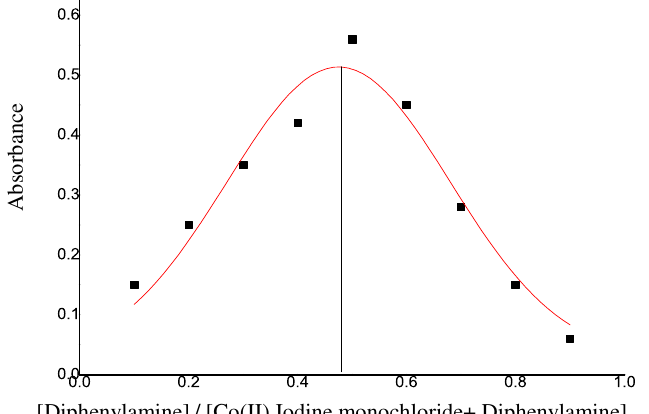
Figure 3. Continuous variation method. [diphenylamine]: 0.01 M [Iodine monochloride]: 0.01 M and Co(II)=0.01